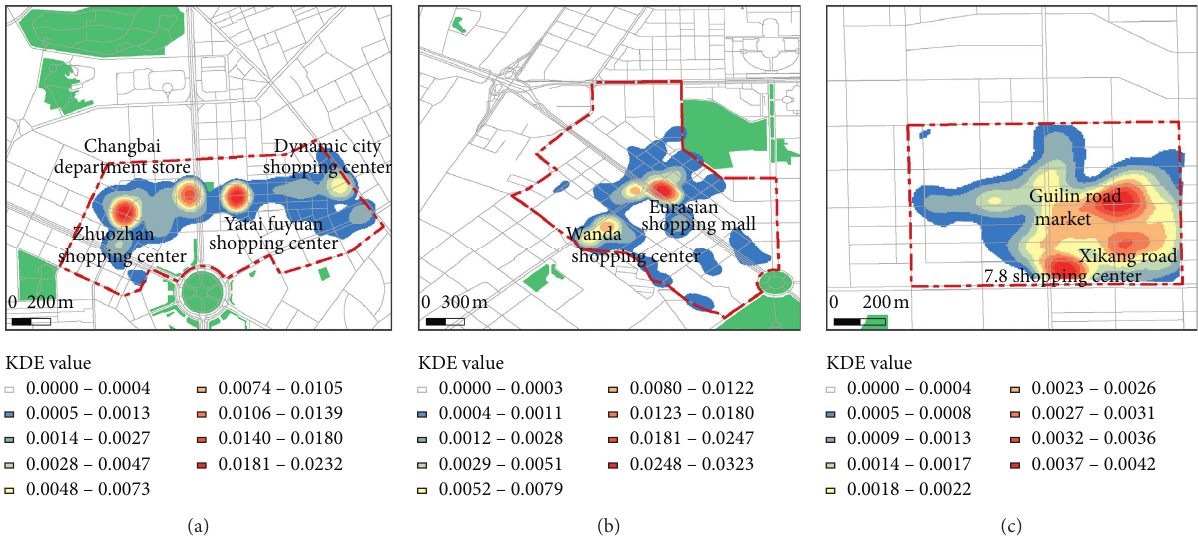
Figure 3: The results of KDE of retail stores in the three major commercial districts in Changchun: (a) Chongqing Road; (b) Hongqi Road; (c) Guilin